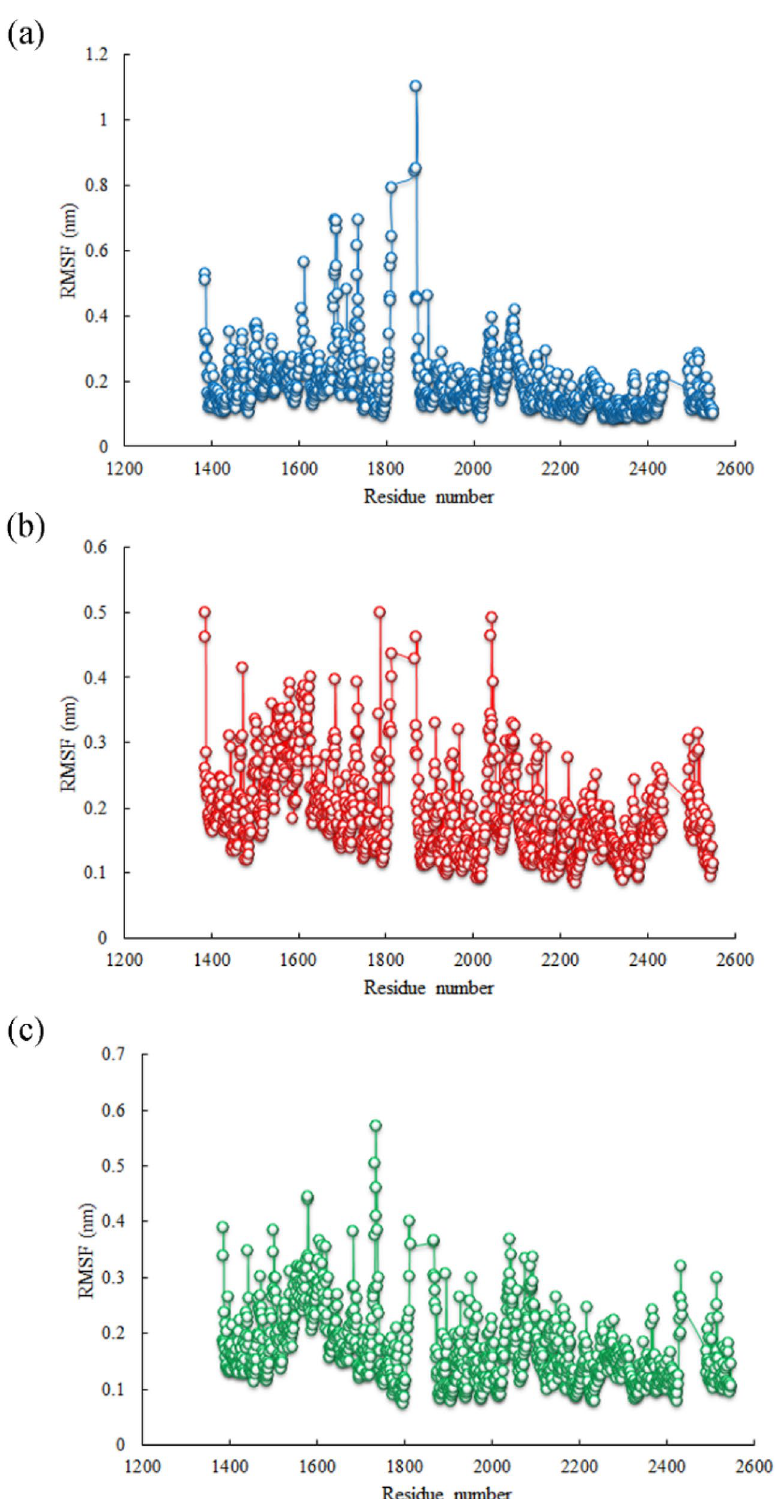
Figure 6. RMSF plots of all residues of the A-chain of mTOR protein in complex with ( a ) Torin2, ( b ) Cyclo trijoglone, ( c ) Sennoside